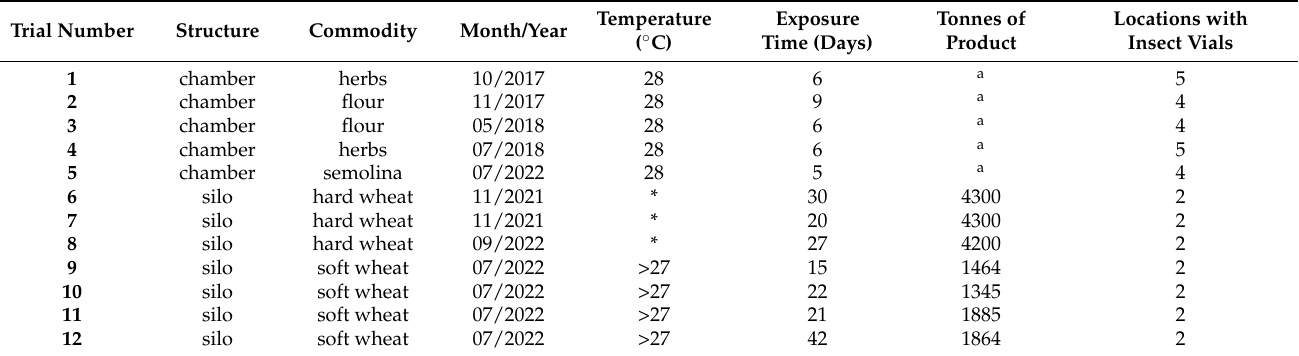
Table 2. Conditions of each trial. (* asterisk indicates that temperature was not estimated and ( a ) indicates that product weight was not